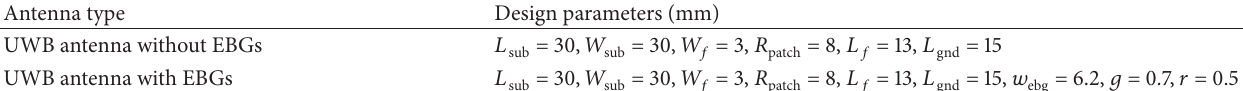
Table 1: Design specifications for UWB antennas.